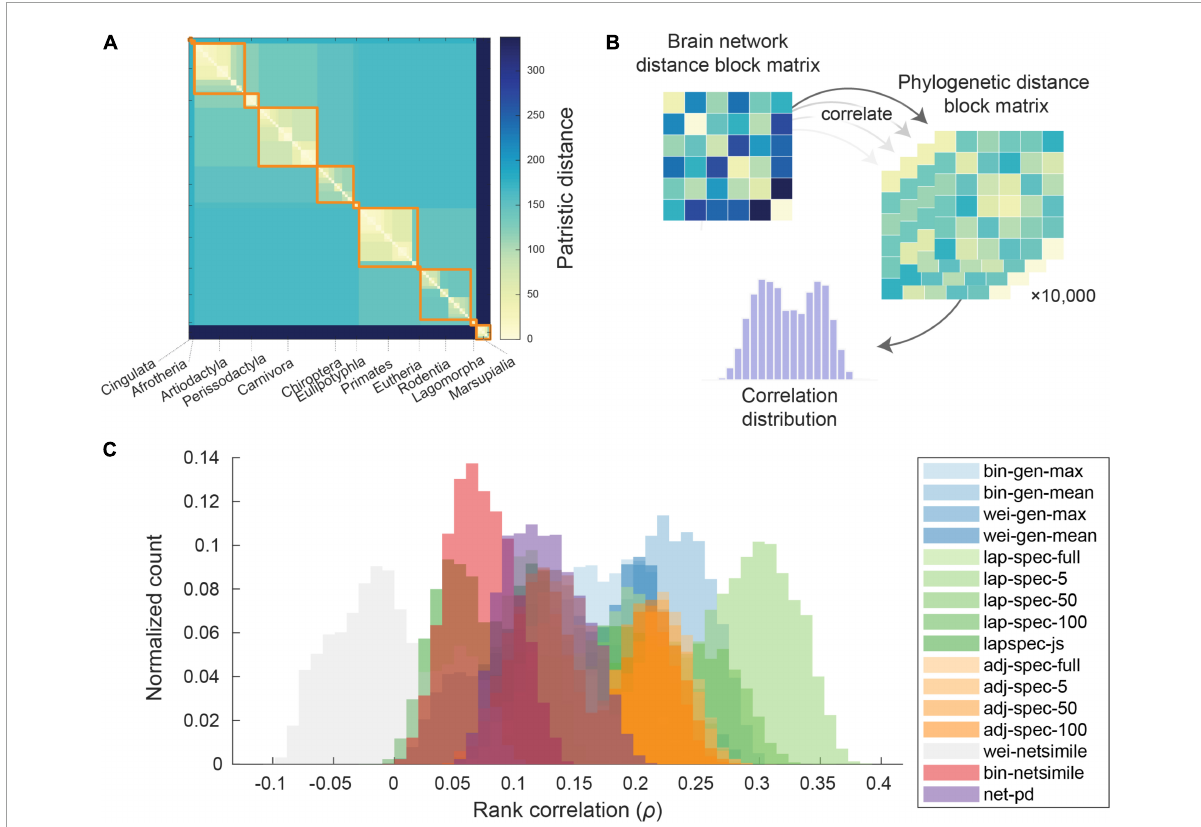
FIGURE3 Network distance correlates with phylogenetic distance. (A) Phylogenetic distance matrix (with dimensions 103-by-103) for all unique mammal species, with taxonomy highlighted via orange on-diagonal blocks. (B) Schematic of the process for correlating brain network distance with multiple phylogenetic distance estimates. (C) For each distance measure, the distribution of Spearman rank correlation coefficients is shown for 10 3 comparisons of block network distance to block phylogenetic distance; distributions are only colored if the bottom 1% correlation value exceeds zero; distributions are colored by distance measure